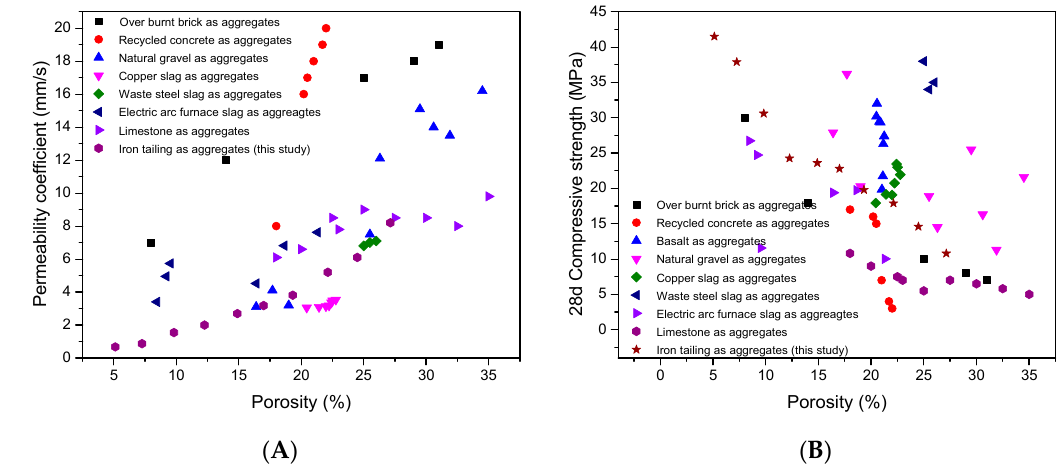
Figure 11. Comparisons of the permeability coefficient ( A ) and compressive strength ( B ) of the pervious concrete with different types of aggregates.